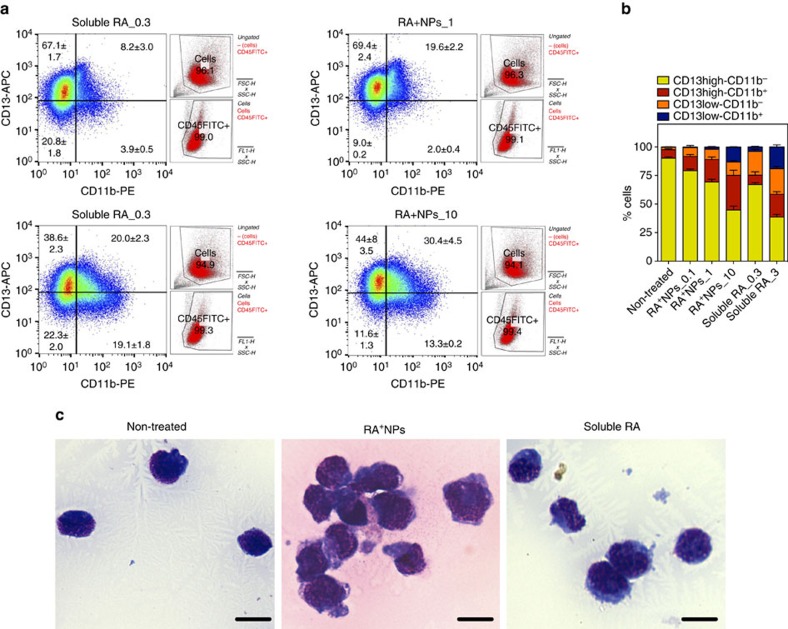
Differentiation profile of NB4+ cells after treatment with soluble RA or RA+NPs.NB4 cells were incubated in serum-free RPMI-1640 with RA+NPs (1 or 10 μg ml−1; RA+NPs_1 and RA+NPs_10, respectively) for 4 h. Then, cells were washed three times with PBS to remove NPs not internalized, activated by UV light (365 nm, 100 W) during 5 min, and cultured in complete medium for additional 3 days. Alternatively, NB4 cells were cultured in complete medium for 3 days having soluble RA (0.3 or 3 μg ml−1; RA_0.3 and RA_3, respectively). (a) Flow cytometry analysis of differentiated NB4 cells cultured for 3 days. Cells were initially gated in an FSC/SSC plot (in red; attached to the scatter plot) and then gated for the expression of CD45 (in red; attached to the scatter plot). Percentages of positive cells were calculated based in the isotype controls and are shown in each scatter plot. Results are expressed as mean±s.e.m. (n=3). (b) Percentages of CD13highCD11b−, CD13highCD11b+, CD13lowCD11b− and CD13lowCD11b+ in NB4 cells differentiated for 72 h. Results are expressed as mean±s.e.m. (n=3). (c) Representative May-Grunwald Giemsa stains of NB4 cells cultured for 72 h after exposure to RA+NPs (10 μg ml−1; therefore 1.2 μg ml−1 of RA) or soluble RA (3 μg ml−1). Bar corresponds to 20 μm.